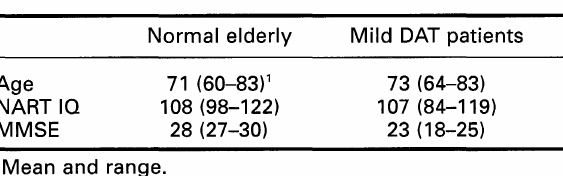
Normal elderly 71 (60-83)' 108 (98-122) 28 (27-30)